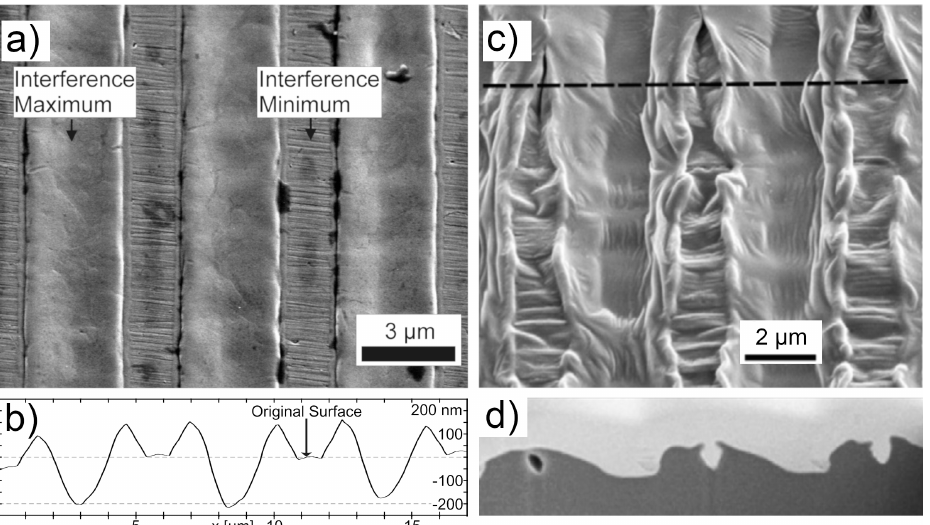
Figure 12. Surface morphologies after two-beam DLIP with a single laser pulse, λ = 355 nm, τ p = 10 ns: ( a , b ) on AISI 304 stainless steel substrate with a period of 5.05 µm and laser fluence 0.6 J/cm 2 [35], ( c , d ) on high-purity aluminium substrate with a period of 4.5 µm and laser fluence 1.015 J/cm 2 [96], scanning electron micrographs of ( a , c ) substrate surfaces, ( d ) cross section at dashed line in ( c ) prepared by focussed ion beam and detail of ( b ) surface profile measured by confocal laser scanning